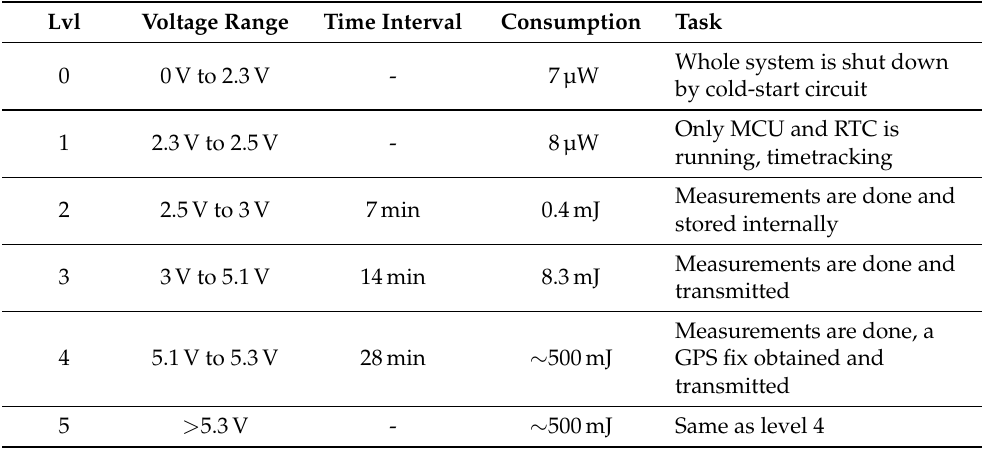
Table 1. The algorithm executes tasks according to a fixed time interval, but only when the capacitor’s voltage is in the desired range or above. Otherwise, it is skipped.